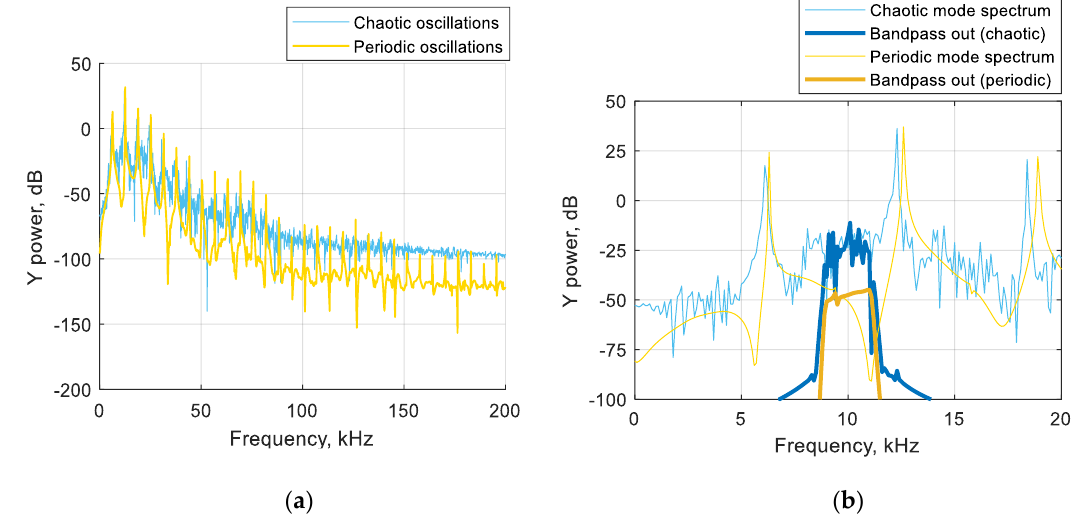
Figure 15. Frequency analysis of sensor oscillations: ( a ) comparison of chaotic and periodic modes spectra; ( b ) spectra of filtered signals with a 9–11 kHz bandpass Chebyshev filter. As chaotic oscillations occupy the frequency band more uniformly, separating the signal band in the section of periodic frequency trough results in the notable increase of signal power when the circuit switches to chaotic mode.